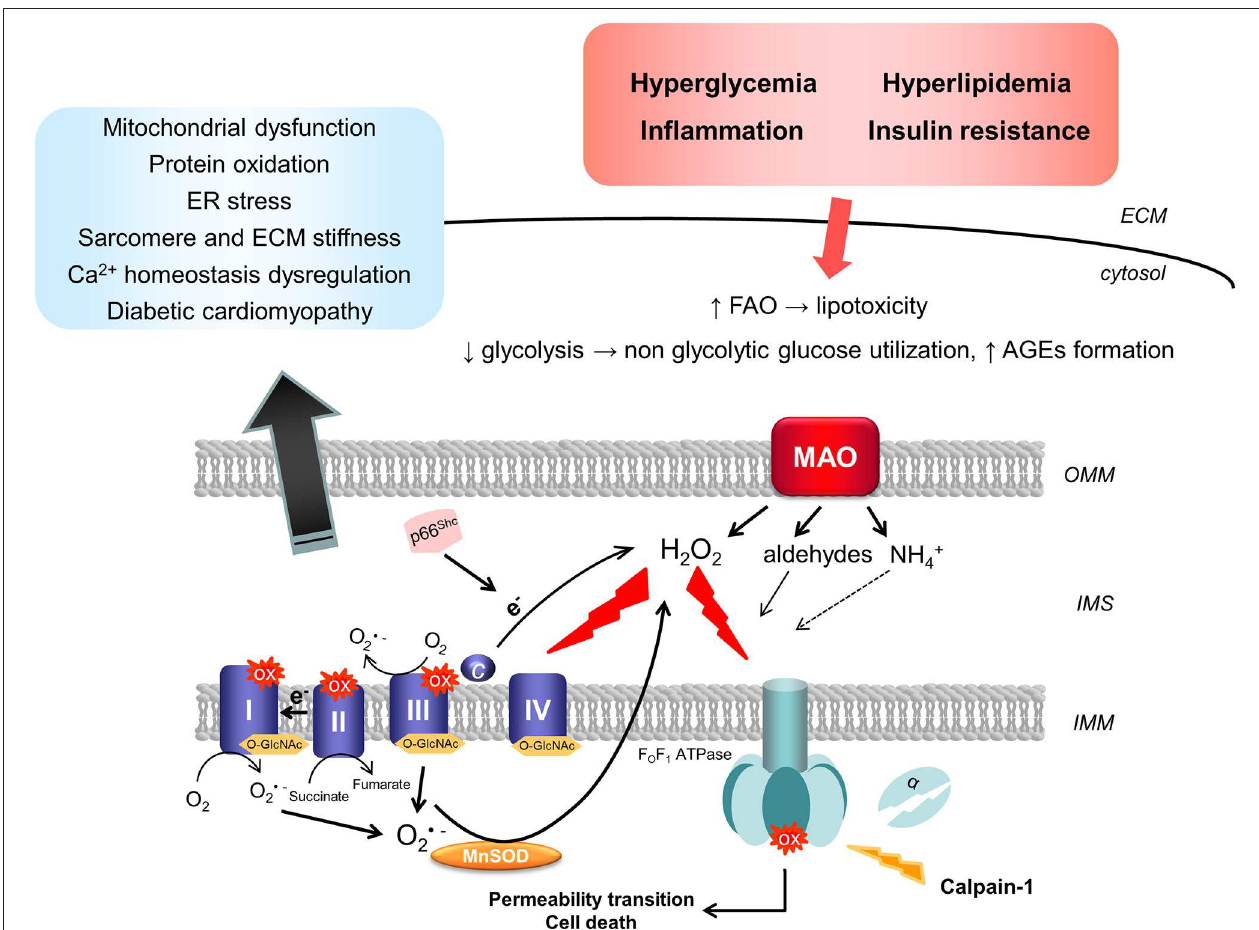
FIGURE 2 | Mitochondrial sources of ROS in diabetic cardiomyopathy. Diabetic milieu, characterized by hyperglycemia, hyperlipidemia, and inflammation, results in the up-regulation in the activity of mitochondrial ROS-producing enzymes. Superoxide can be produced by the respiratory chain through forward or reverse electron transport. In addition, calpain-1 translocates to the mitochondrial matrix in the diabetic heart and cleaves the α subunit of the ATP synthase, leading therefore to the reduction in its activity and mitochondrial dysfunction. On the other hand, in situations of stress, p66 Shc is phosphorylated and translocates to the IMS where it catalyzes the electron transfer from cytochrome c to oxygen (O 2 ) leading to the formation of hydrogen peroxide (H 2 O 2 ). Finally, up-regulation of MAO activity upon exposure to high glucose and pro-inflammatory stimuli results in enhanced formation of H 2 O 2 that can directly increase the susceptibility of mitochondria to undergo permeability transition. Post-translational modifications, such as oxidation or O-GlcNAcylation of respiratory chain complexes, can impair mitochondrial bioenergetics and function. All these events are implicated in the pathogenesis of diabetic cardiomyopathy by promoting mitochondrial and ER stress, leading to protein oxidation and Ca 2 + homeostasis impairment, as well as sarcomere and ECM stiffness. AGEs, advanced glycation end products; ECM, extracellular matrix; ER, endoplasmic reticulum; FAO, fatty acid oxidation; IMM, inner mitochondrial membrane; IMS, intermembrane space; MAO, monoamine oxidase; MnSOD, manganese superoxide dismutase; OMM, outer mitochondrial membrane; O-GlcNAc, β -linked N-acetylglucosamine; ox,